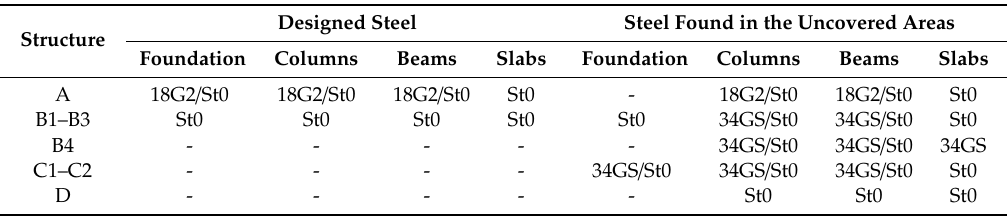
Table 2. Designed and applied (tested) reinforcing